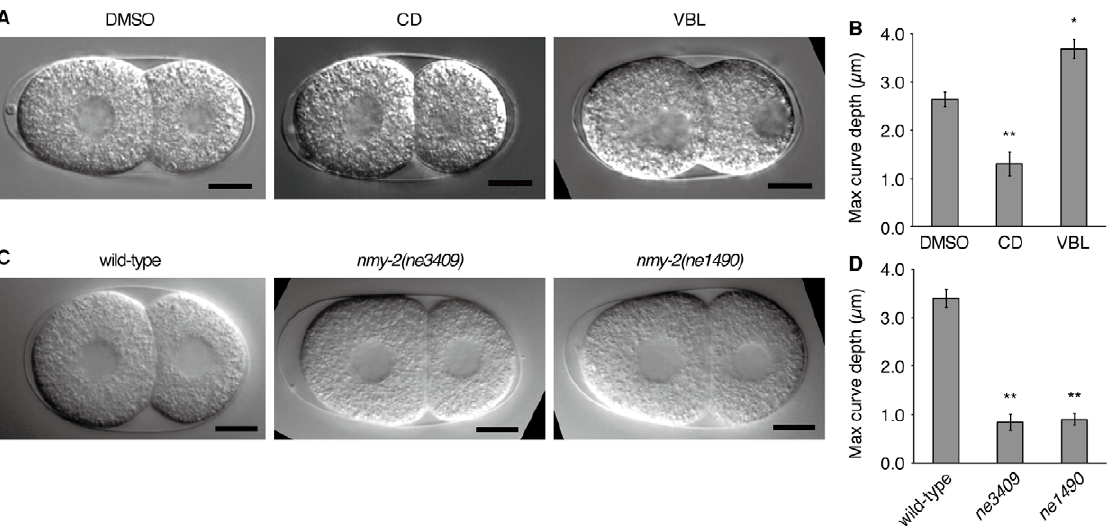
Figure 3. Curvature of the contact surface is dependent on actomyosin. (A) DIC images of embryos treated with cytoskeletal inhibitors. CD, cytochalasin D; VBL, vinblastine. Images were taken 8 min after the onset of the two-cell stage. (B) Maximum curve depth of the drug-treated embryos (n=10 each). (C) DIC images of ts mutants of nmy-2 at the restrictive temperature. Images were taken immediately before NEBD of AB. (D) Maximum curve depth in the nmy-2 embryos at the restrictive temperature (n=10 each). Error bars indicate s.e.m. *, P , 0.01; **, P , 0.001; Mann– Whitney test. Scale bars, 10 m m.